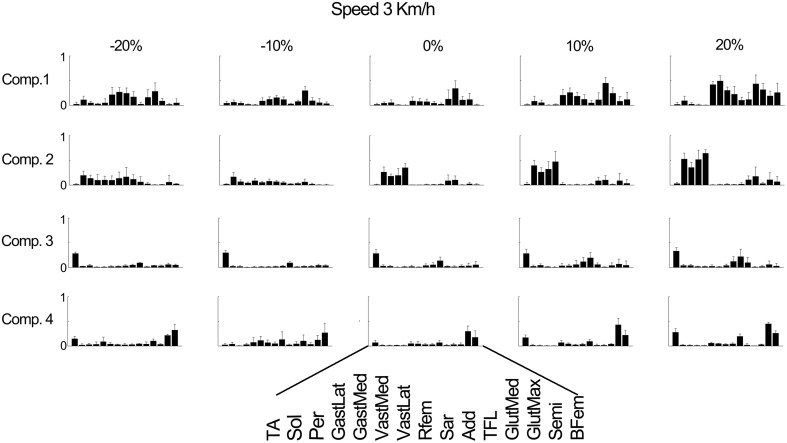
Weighting coefficients for 15 muscles in four components at the speed of 3 km/h and across elevations. The bars represent the average amplitude (mean ± standard deviation) for seven subjects.